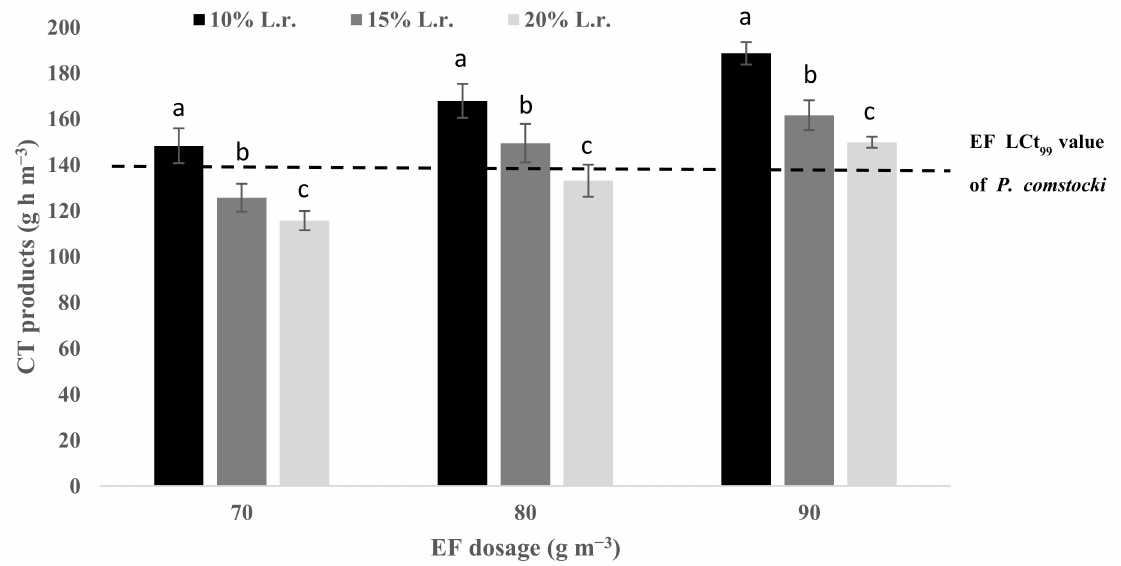
Figure 2. Ct product depending on the concentration and various loading ratios of grapes (Campbell Early) after fumigation with ethyl formate (EF) for 4 h at 5 ◦ C. Lowercase letters above the bars (a, b, and c) show significant differences at p < 0.05 based on Ducan’s multiple range